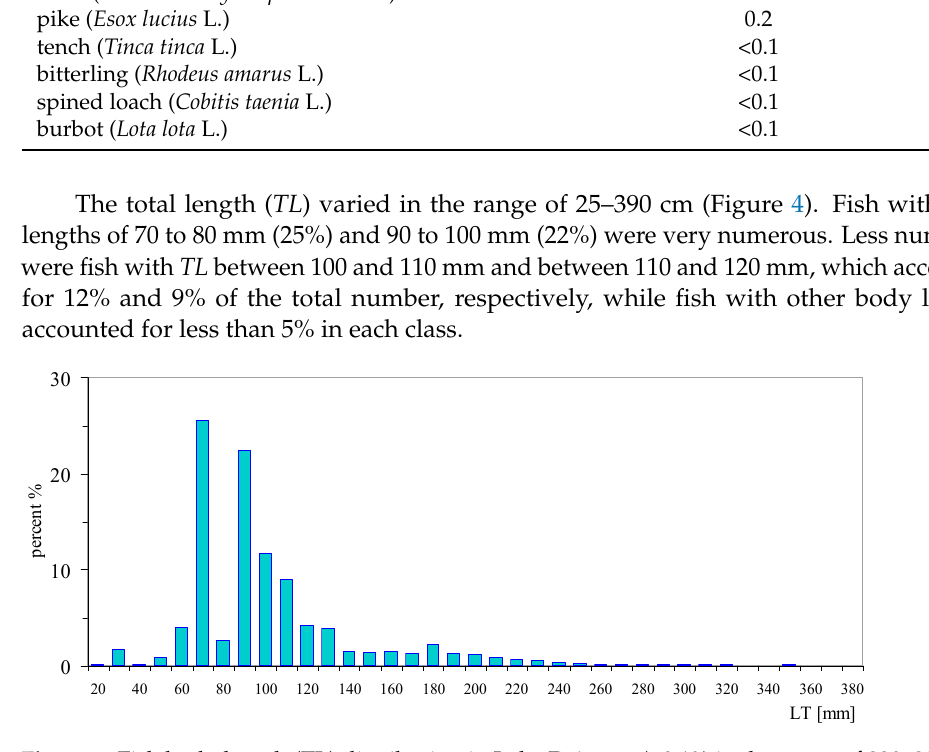
Figure 4. Fish body length (TL) distribution in Lake Dejguny (<0.1% in the range of 330–390 mm), based on catches made with Nordic multimesh gillnets on 27–30 September 2021.